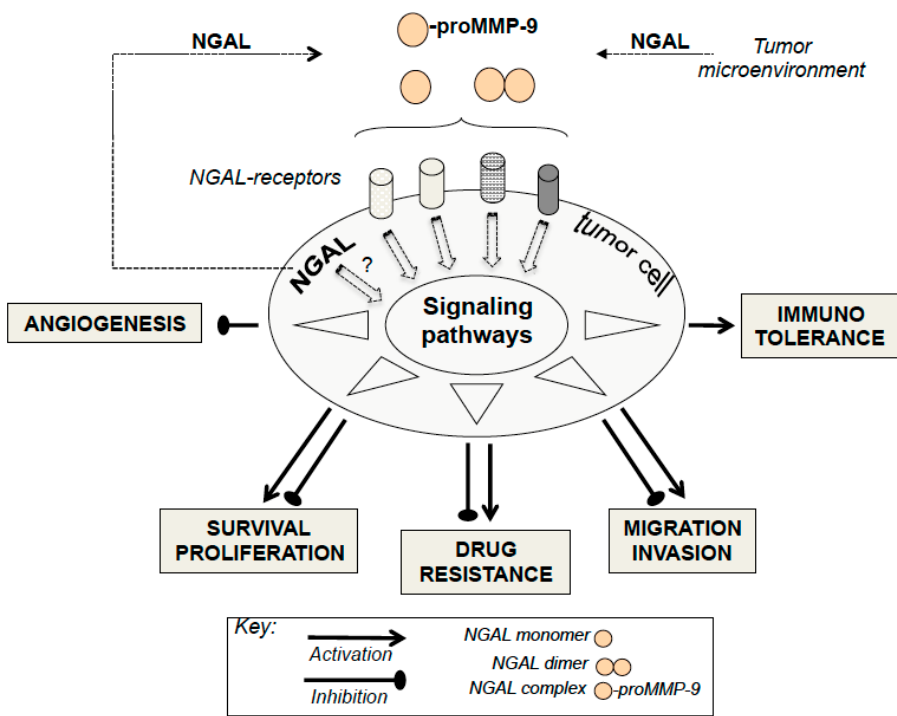
Figure 1. Schematic Diagram Illustrating the Putative Roles of neutrophil gelatinase-associated lipocalin (NGAL) in Modulating Major Cellular Processes. The synthesis and release of tumor NGAL (monomer, dimer, or complex) increase in response to various stimuli (inflammatory cytokines, hypoxia etc.). Extracellular NGAL binds to specific cell surface receptors (megalin, SLC22A7 isoforms) on tumor cells, and thus may activate or inactivate signaling pathways. In turn, this modulates proliferation, survival, migration, invasion, angiogenesis, immunotolerance, and multidrug resistance—all events involved in tumor biology. A given cell type may be involved in the NGAL-mediated actions reported here to a variable extent. Intracellular NGAL might be directly involved in the modulation of cell responses. The NGAL complex’s possible effects on tumor cells remain to be identified.